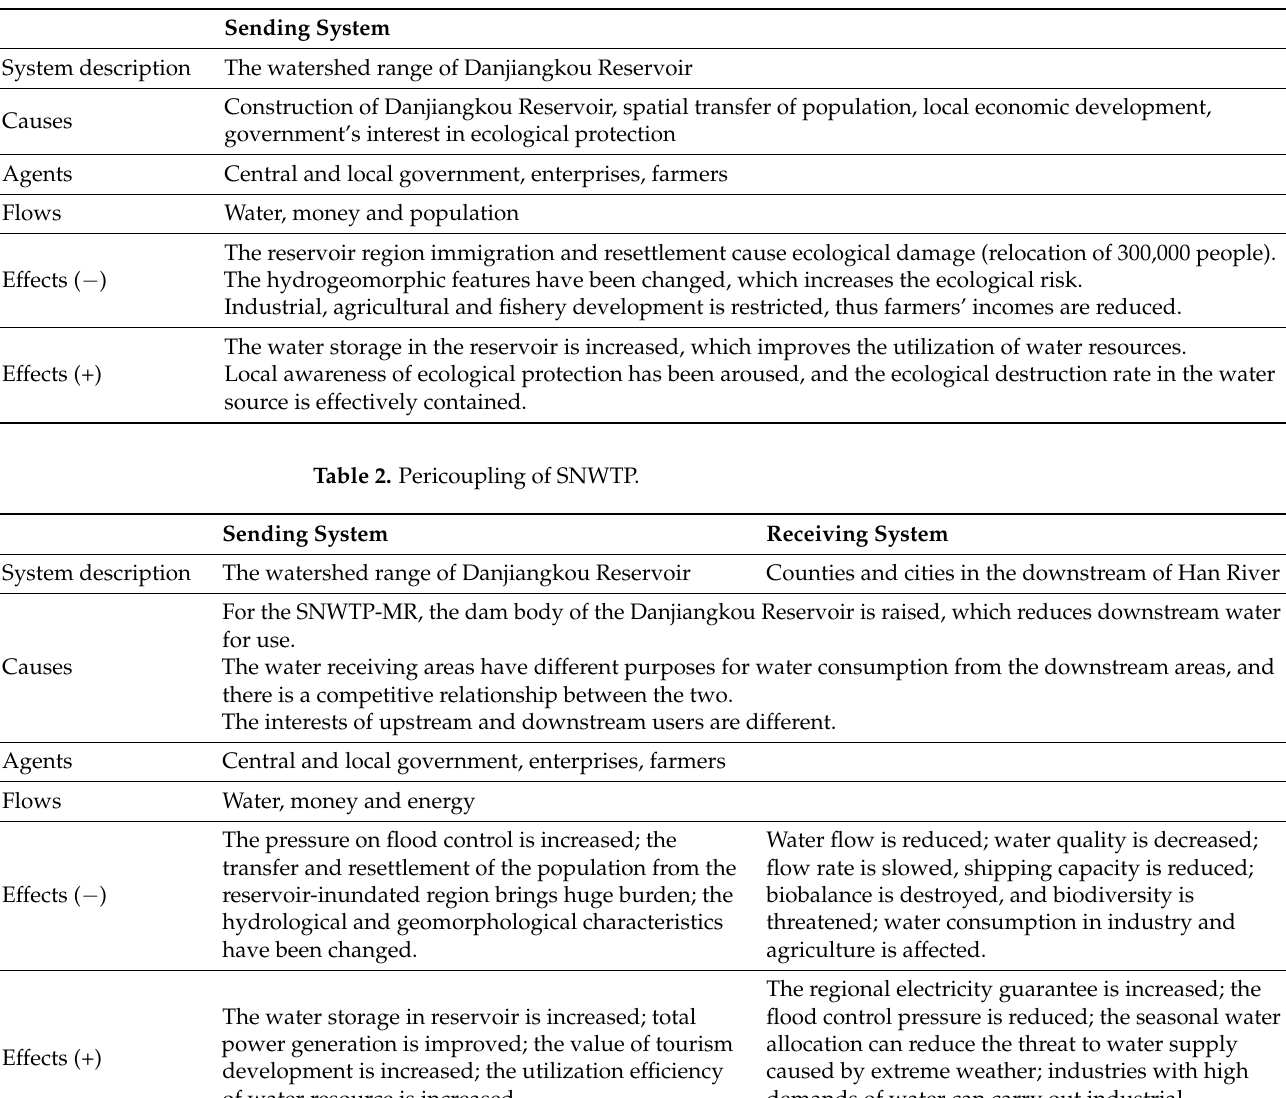
Table 1. Analysis of the intracoupling framework of SNWTP.